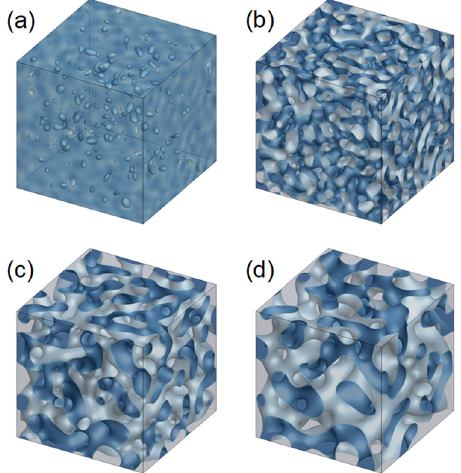
Figure 4. Snapshots depicting the evolution of pore morphology at the inside part of the membrane, which was obtained with an initial polymer concentration of ϕ 0 = 0.20, by applying the periodic boundary condition in all directions. Snapshots were obtained at t * = ( a ) 0.02, ( b ) 0.04, ( c ) 0.30, and ( d ) 0.80. The isosurfaces of ϕ = 0.15 are depicted. The blue- and gray-colored areas represent the polymer-rich and solvent-rich phases, respectively.